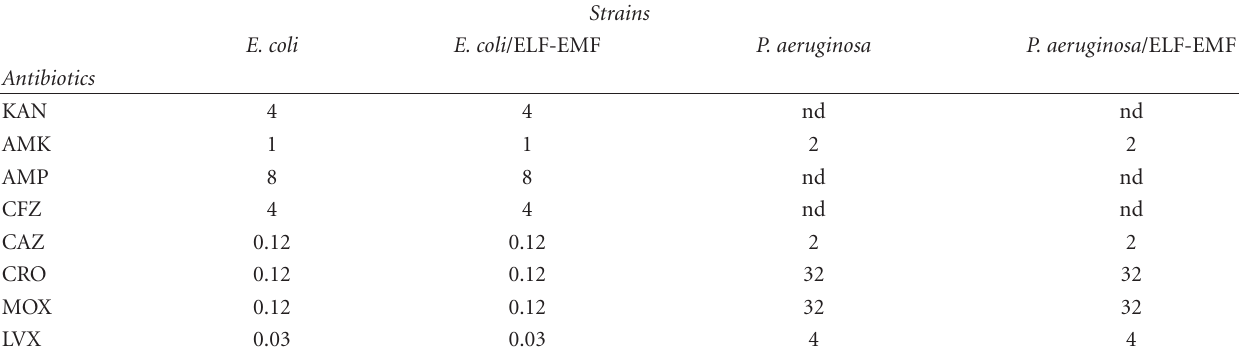
Table 1: MIC values ( µ g/mL) for E. coli and P. aeruginosa exposed or not exposed to ELF-EMF (sinusoidal wave; 2mT; 50 Hz). Strains E. coli E. coli